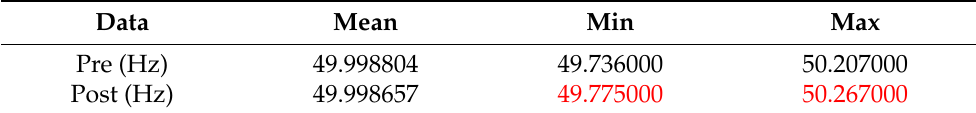
Table 2. Comparison of descriptors to quantify the changes in the system frequency pre- and post- lockdown mitigation actions. The increase in the post-action minimum and maximum frequency is highlighted by the red text